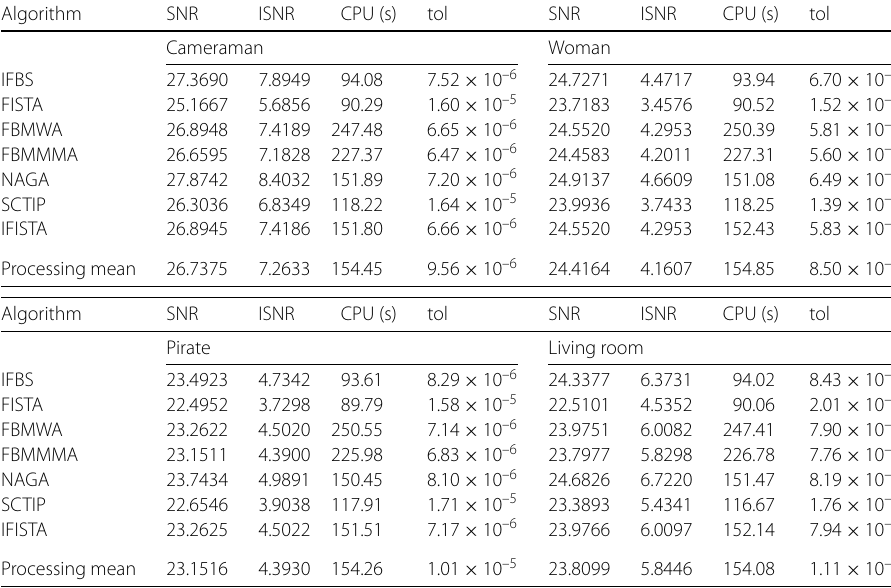
Table 3 The SNR and ISNR values at first 1000 th iterations for image deblurring